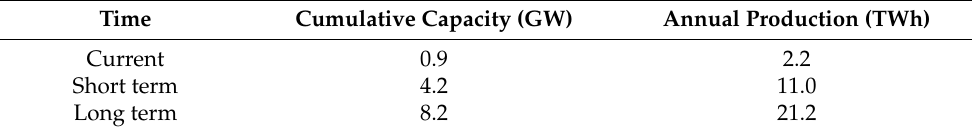
Table 5. Estimated wind power capacities in the Oulu